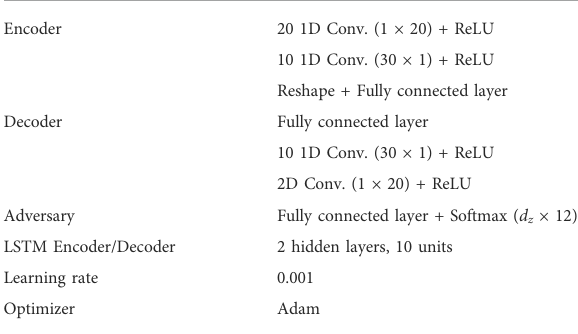
TABLE 1 Network architectures and parameters.